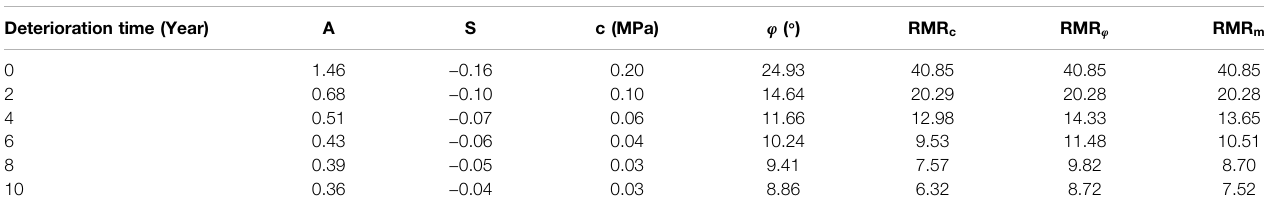
TABLE 4 | Time-dependent parameters of rock mass during